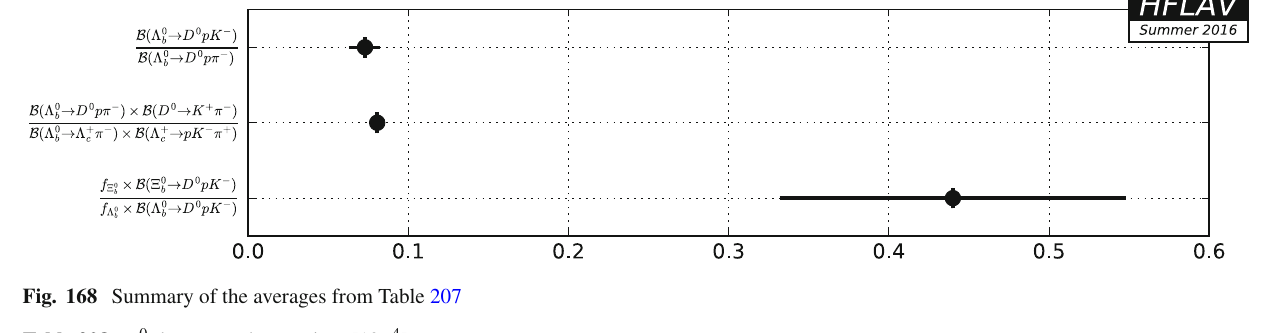
Fig. 168 Summary of the averages from Table 207 Table 208 Λ 0 decays to charmonium [ 10 − 4 ] b